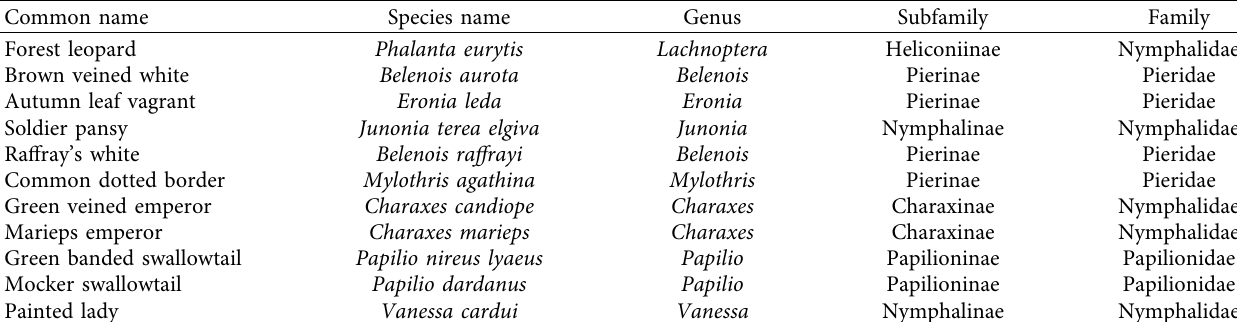
Table 3: List of butterfly species recorded in the study